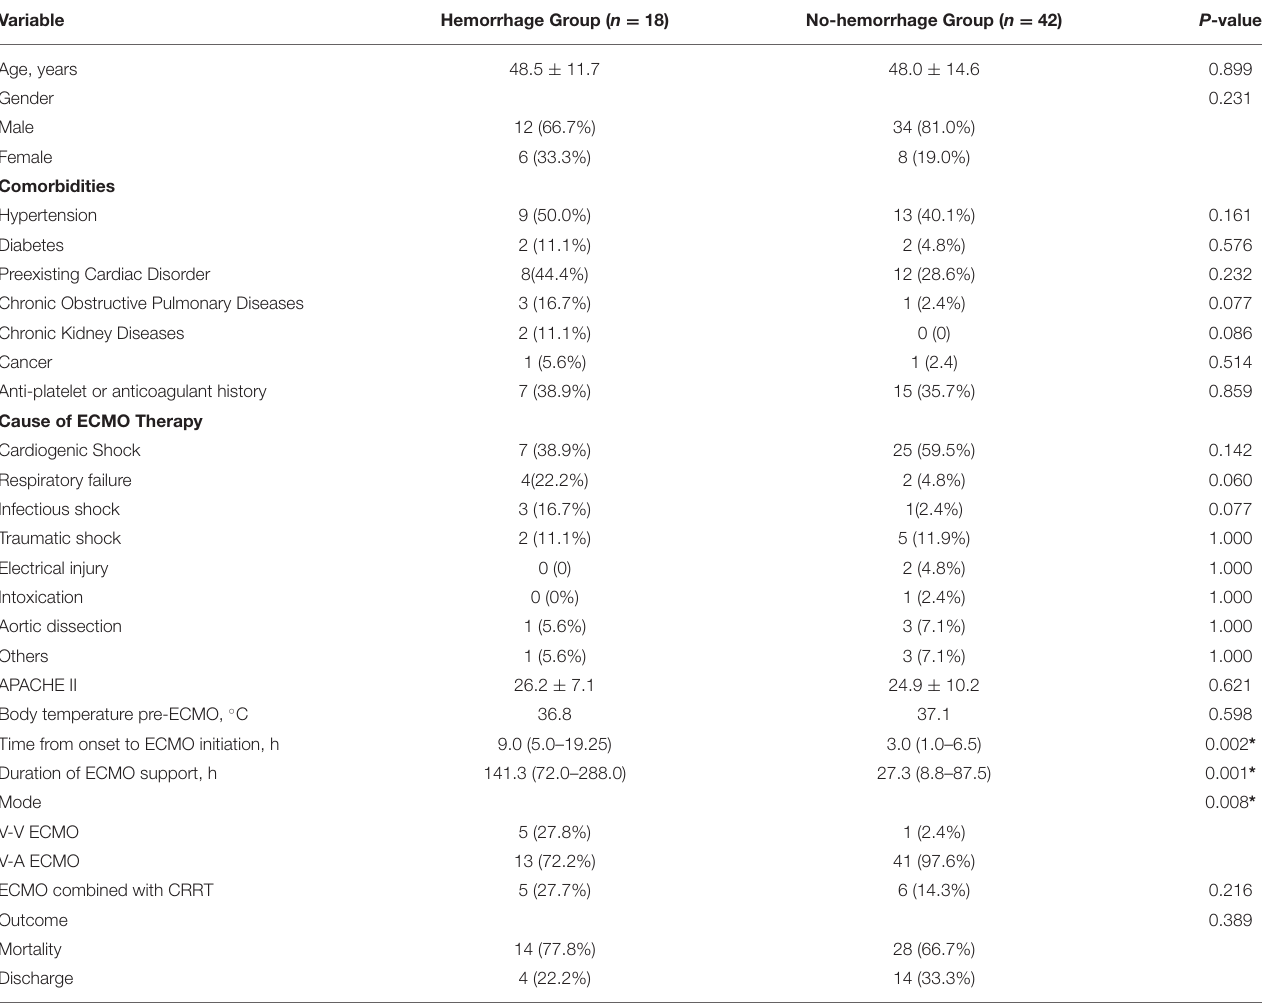
TABLE 1 | Demographics and clinical characteristics of patients. Variable